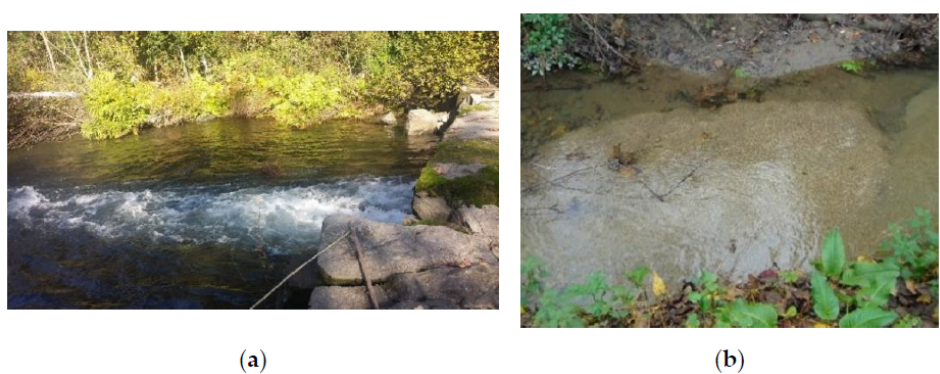
Figure 4. Aspects associated with Section C: ( a ) Pools; ( b ) Unvegetated point bar.